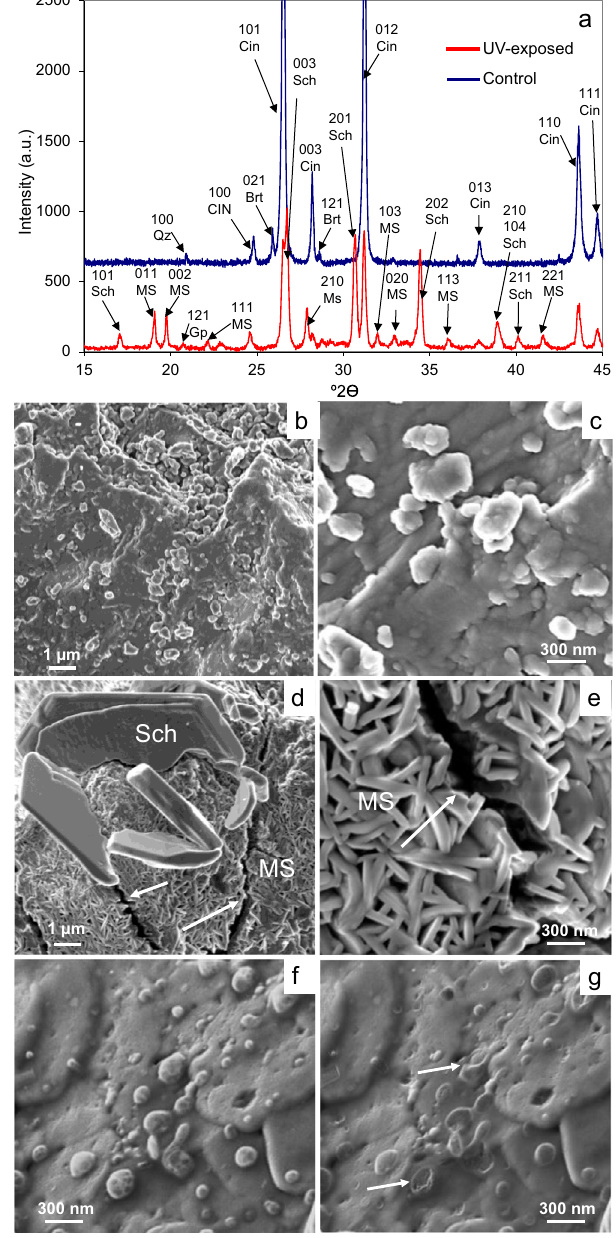
Fig. 3 XRD patterns and FESEM images of unaltered and UV-exposed cinnabar pigment. a XRD patterns of unaltered (control) and UV- exposed cinnabar pigment after 2-month aging. Sch schuetteite, MS mercury sulfate hydrate, Cin cinnabar, Qz quartz, Gp gypsum, Brt barite (mineral abbreviations, except schuetteite and mercury sulfate hydrate, according to Whitney and Evans 70 ; b , c FESEM images of the unaltered pigment showing a rough surface and nano-sized particles; d detail of the UV-exposed pigment surface showing cracks (arrows) and relatively large plate-like crystals (5 – 10 μ m in size) corresponding to schuetteite; e close-up view of the UV-exposed pigment surface showing cracks (arrow) and small plate-like crystals (mercury sulfate hydrate), which form star-shaped structures and cover the entire pigment grain surface; f , g droplets (presumably mercury) on UV-exposed pigment surface before and after electron beam impact causing evaporation